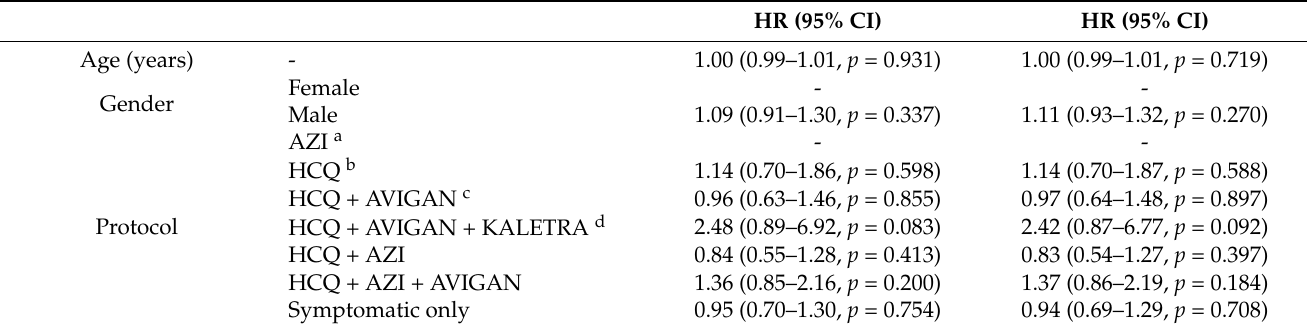
Table 2. Cox regression model to assess the effects of the age and gender of patients administered different antiviral protocols.